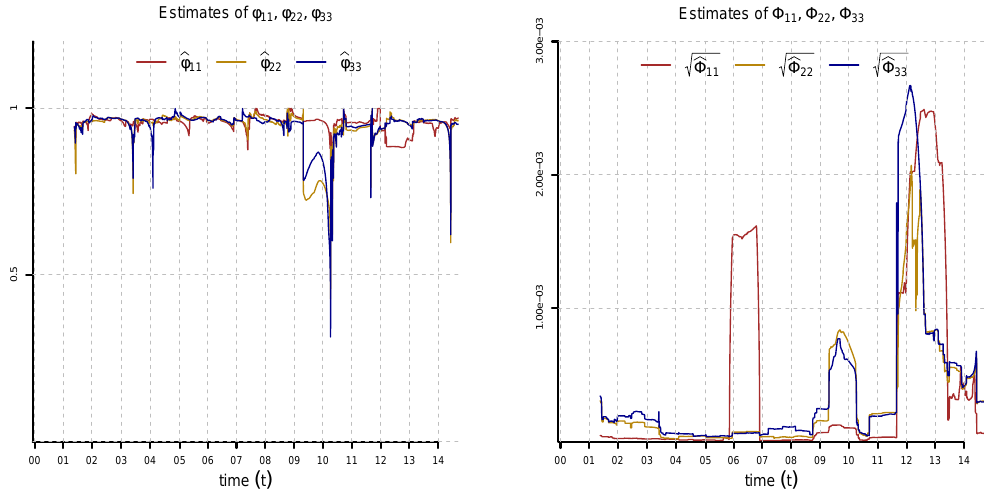
Figure 17. Estimation of φ 11 , φ 22 and φ 33 (lhs) and Φ 11 , Φ 22 and Φ 33 (rhs) by least square regression. We use a time window of 252 observations for the